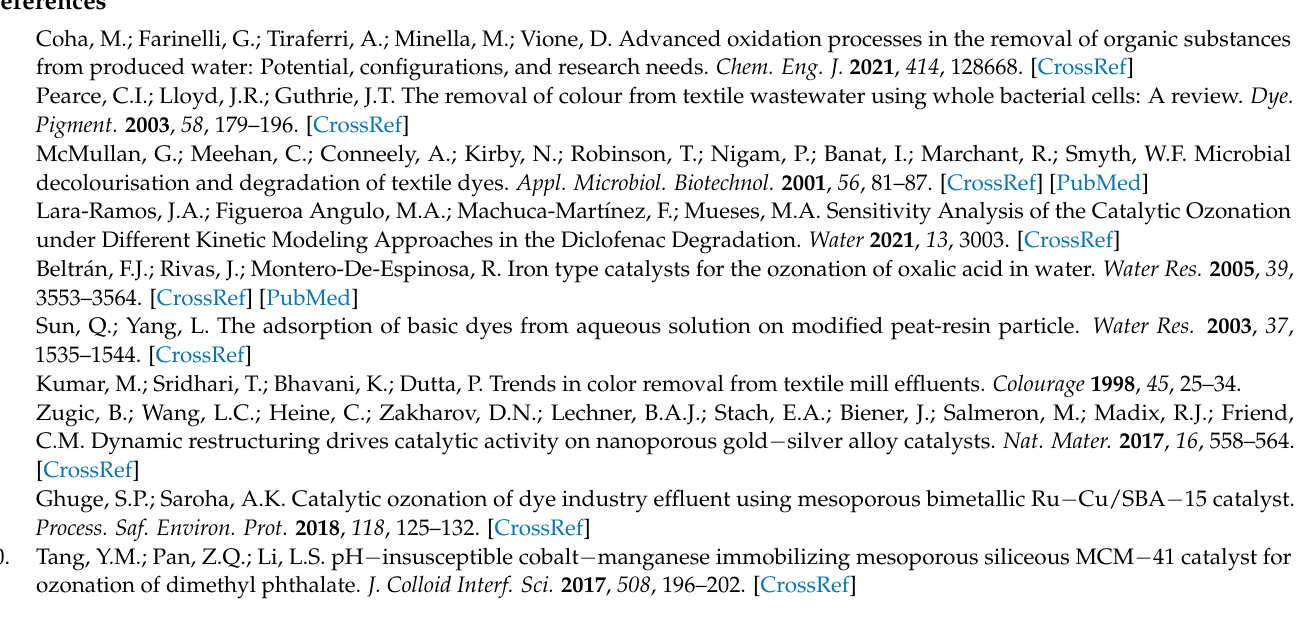
species, Table S4: XPS parameters of high − resolution Mn 2p 3/2 , Fe 2p 3/2 , and O 1s regions, Table S5: Parameters of different real water